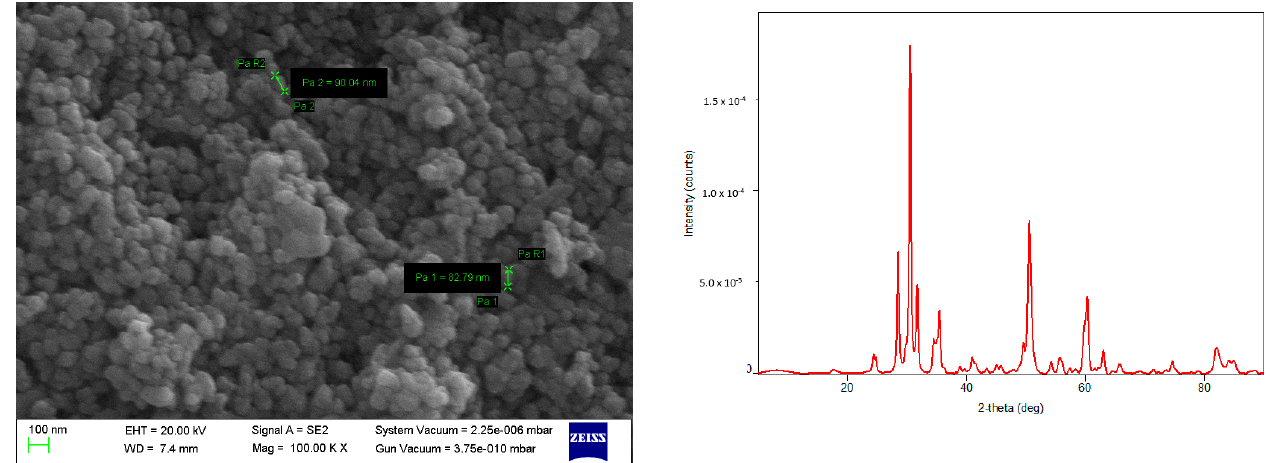
Figure 2. SEM and XRD of a CSZ powder sample with 12 mol% of CaO.